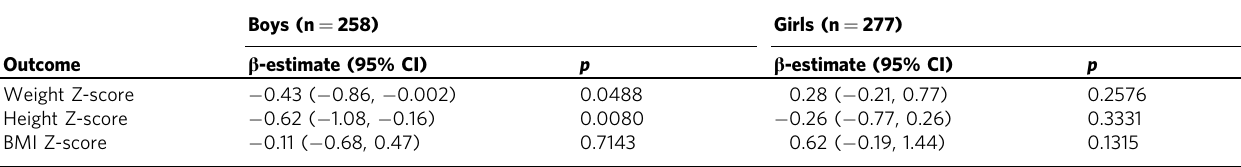
β -estimates for weight, height, and BMI Z-scores with 95% con fi dence interval (CI) and p -values for t-statistics are presented for children of age 0.5 – 5 years after neonatal infection and antibiotic therapy vs no neonatal infection, grouped by offspring sex. Data is based on hierarchical linear mixed model for repeated measurements adjusted for gestational age, birth weight Z-score, mode of delivery,child ’ sage,maternalprepregnancyBMI,intrapartumantibiotictreatment,andanybreastfeedingduringthe fi rst6monthsoflife.Additionally,aninteractiontermbetweenneonatalinfectionand child ’ s age is included. Only children with complete covariate sets and at least one BMI Z-score between 6 months and 5 years are